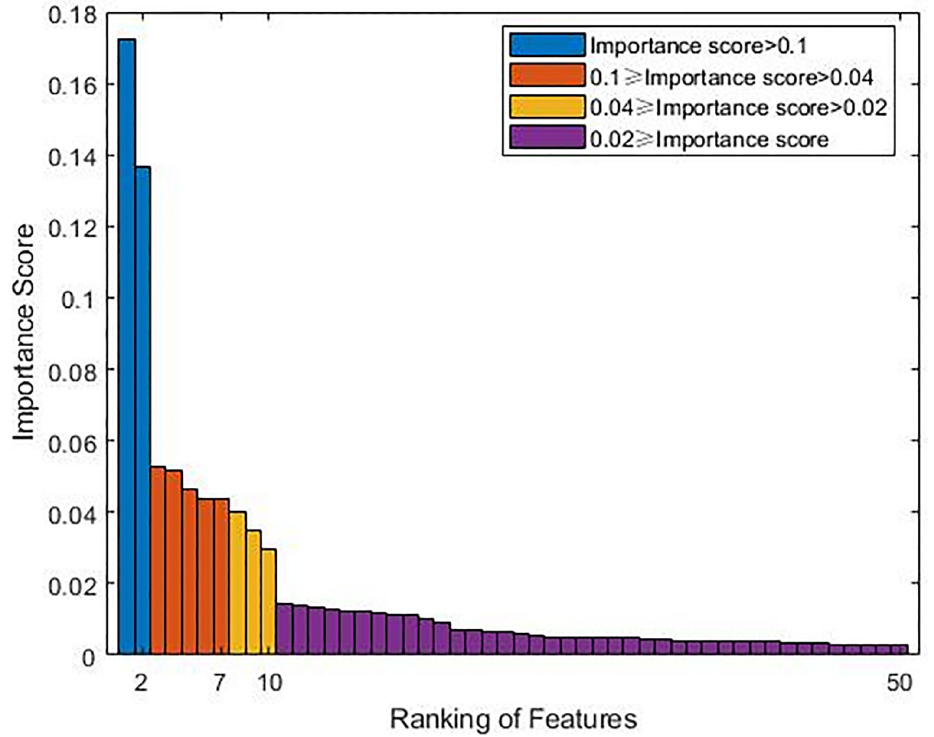
Fig 4. Bar graph of the top 50 features in terms of the importance score.